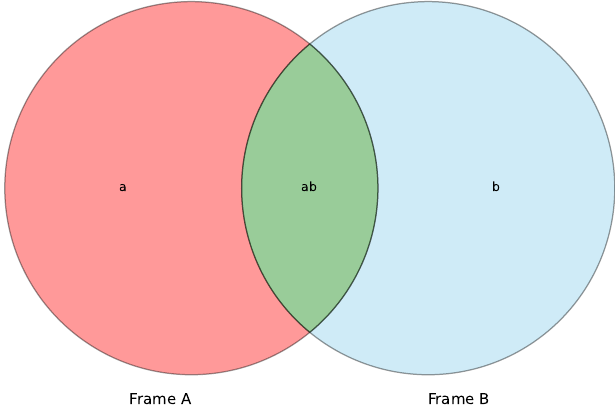
Figure 1. Example of a dual-frame situation.